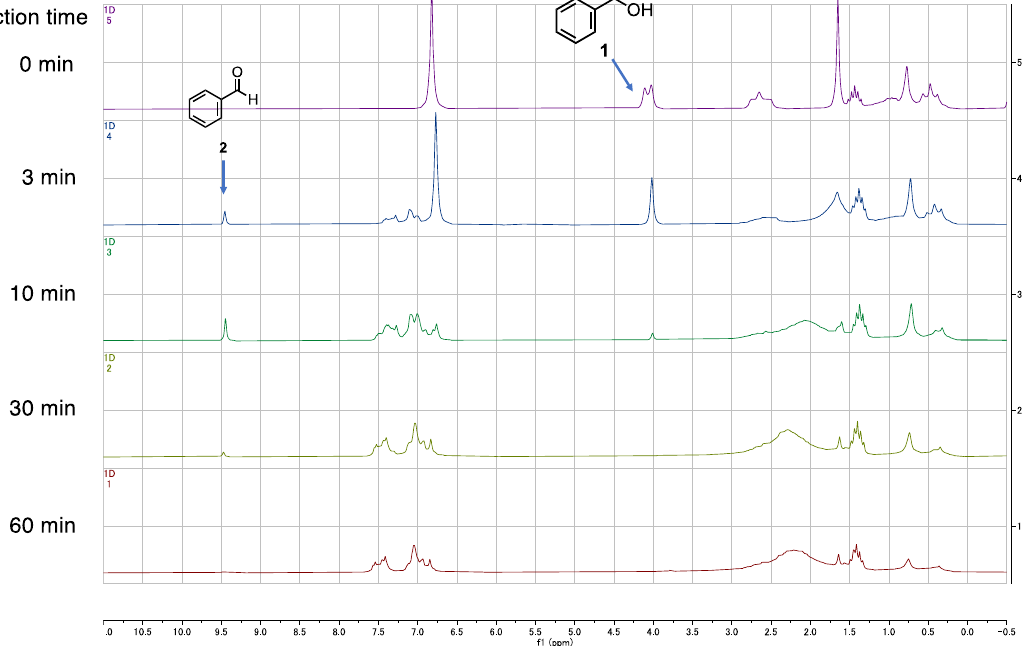
Micromachines 2021 , 12 , x FOR PEER REVIEW Figure 4. Stacked 1 H NMR spectra (60 MHz) by time function. Figure 4. Stacked 1 H NMR spectra (60 MHz) by time function.